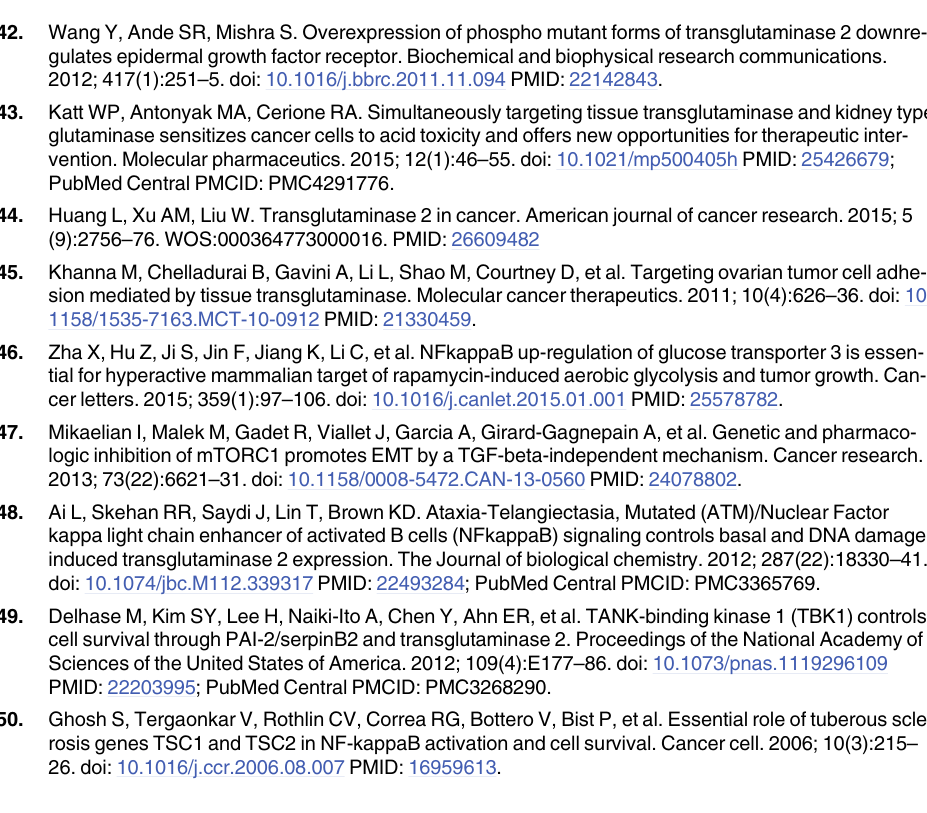
PLOS ONE | DOI:10.1371/journal.pone.0149388 February 12,